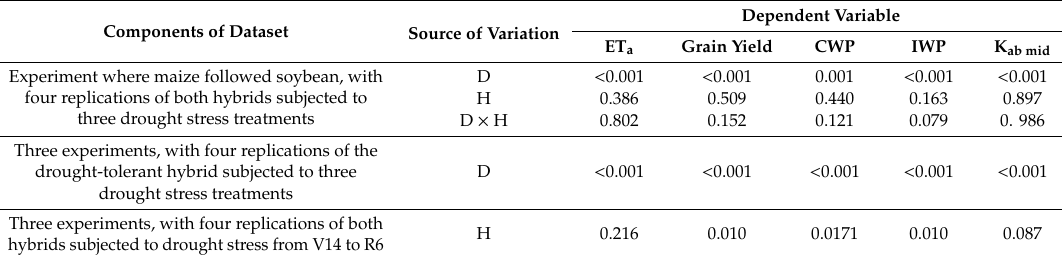
Table 5. Significance of F tests ( P > F ) for fixed sources of variation involving drought stress treatment (D) and hybrid (H) on maize seasonal actual crop evapotranspiration (ET a ), grain yield, crop water productivity (CWP), irrigation water productivity (IWP), and mid-season actual basal crop coe ffi cient (K ab mid ) for treatments with the optimal nitrogen